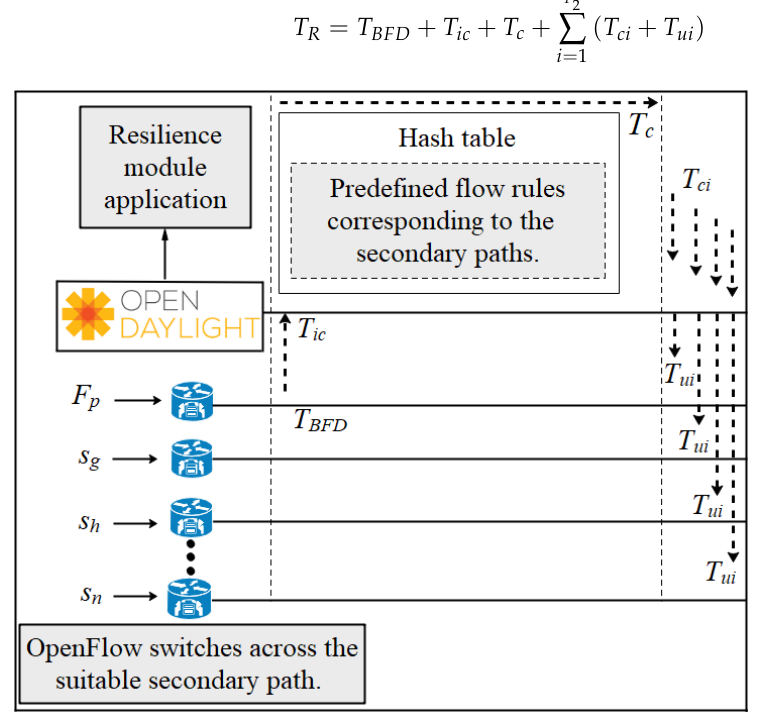
Figure 7. Analytic model for the MFR recovery